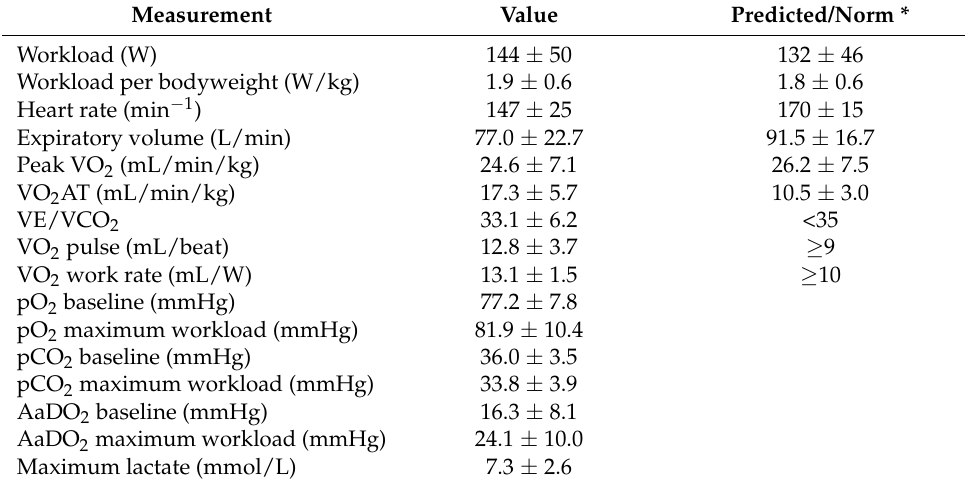
Table 2. Cardiopulmonary exercise testing of the patients (n =